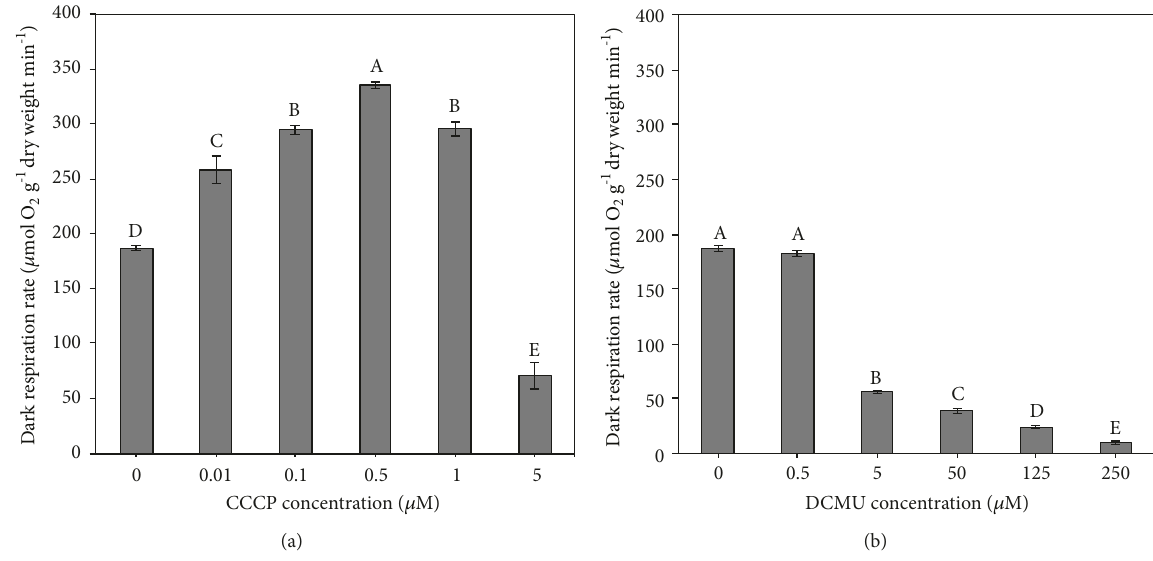
Figure 5: Effects of various concentrations of carbonyl cyanide m-chlorophenyl hydrazone (CCCP) (a) and 3-(3,4-dichlorophenyl)-1,1- dimethylurea (DCMU) (b) on dark respiration rate of Aphanothece halophytica after 2 hours of treatment under illumination. Data are means ± SD (n = 3). Different letters on columns indicate a significant difference according to Duncan’s multiple range test at p < 0.05.